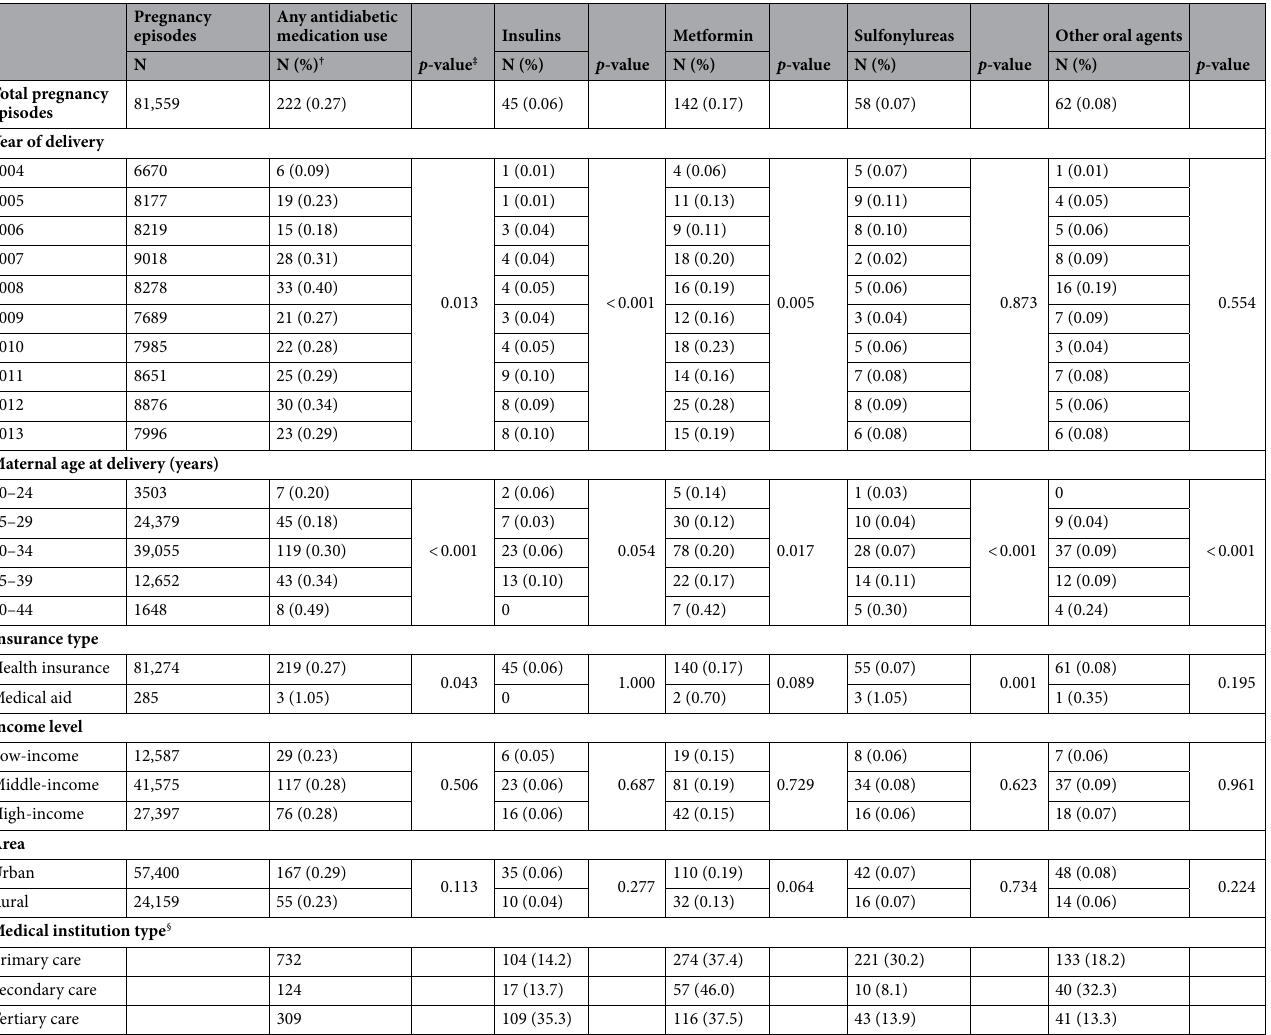
Table 2. Utilization of antidiabetic medications in the pre-conception period by drug class* and maternal characteristics, 2004–2013 (N = 81,559). *When a pregnant woman was prescribed two or more drug’s active ingredient, each ingredient was separated individually. † All percentages are row percentage with pregnancies corresponding to each row. ‡ The p -value s denote comparison between pregnancies with and without prescriptions of each drug class. The χ 2 test or Fisher’s exact test was used for variables of insurance type and area, and the Cochran-Armitage trend test was used for variables of the calendar year, maternal age, and income level. p values of < 0.05 were significant. § In the case of medical institution type, we used the number of prescriptions, not the number of